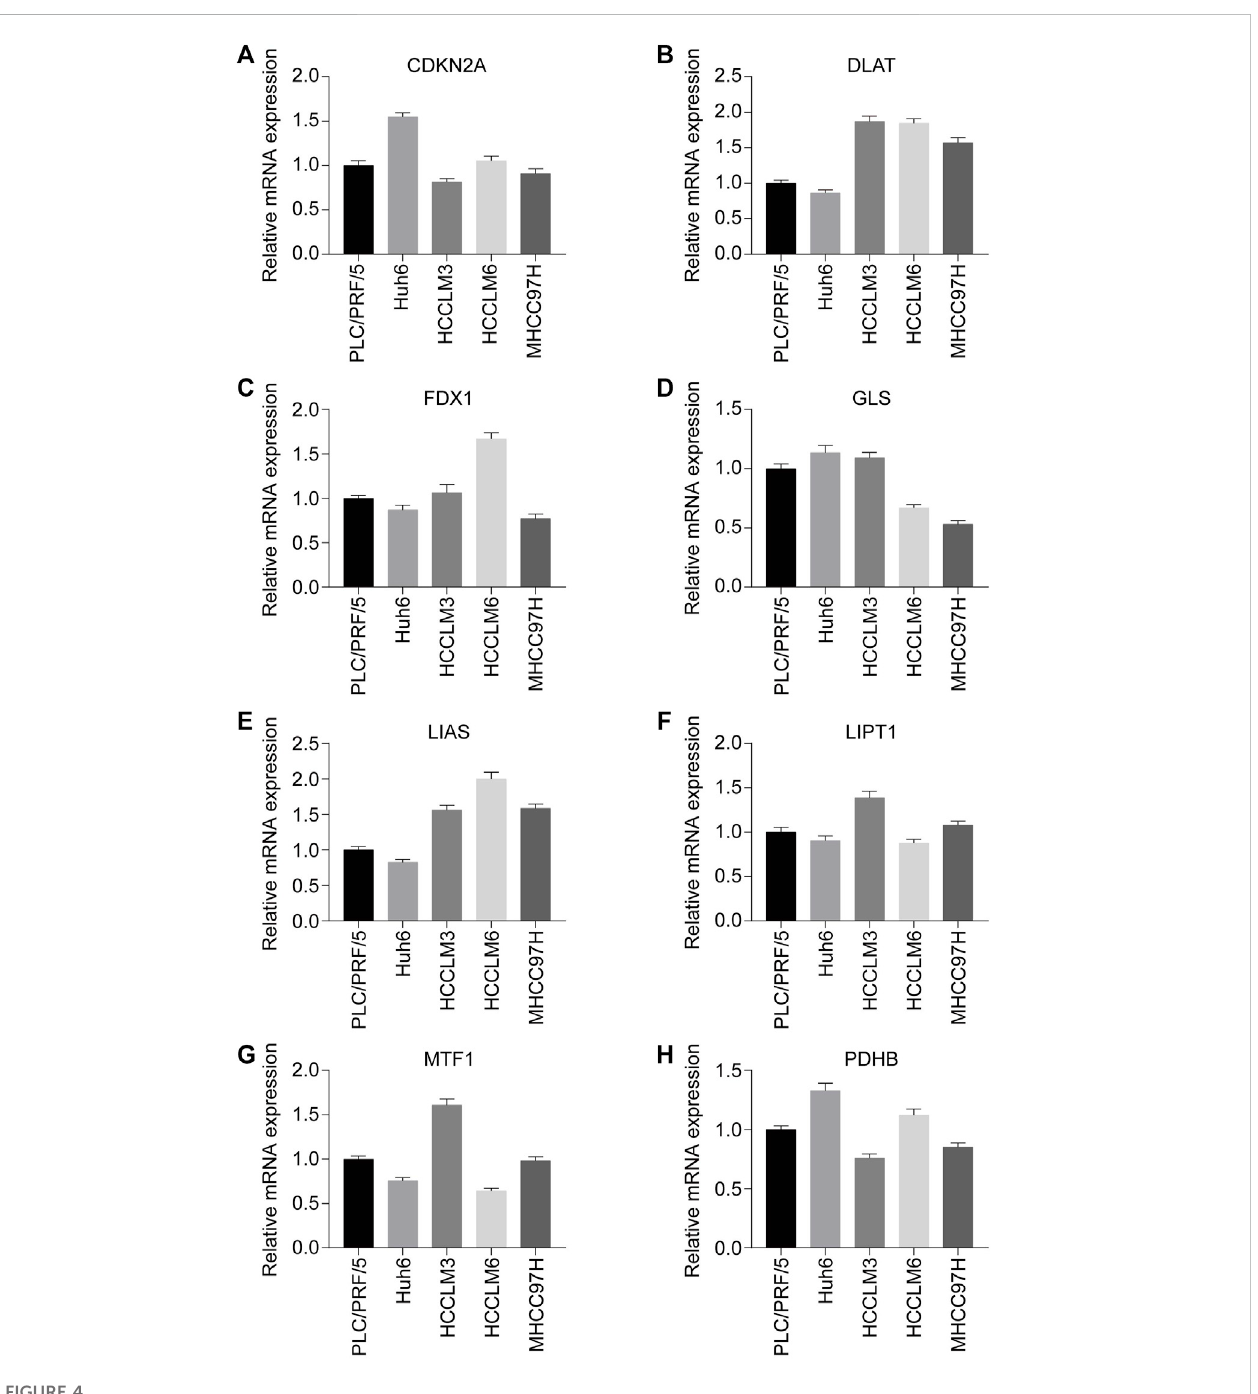
FIGURE 4 Expression status of CRGs with prognostic values in HCC cell lines (PLC/PRF/5, Huh6, HCCLM3, HCCLM6, MHCC97H) were assessed by RT-qPCR. (A) CDKN2A . (B) DLAT . (C) FDX1 . (D) GLS . (E) LIAS . (F) LIPT1 . (G) MTF1 . (H) PDHB . * p < 0.05, ** p < 0.01, *** p <